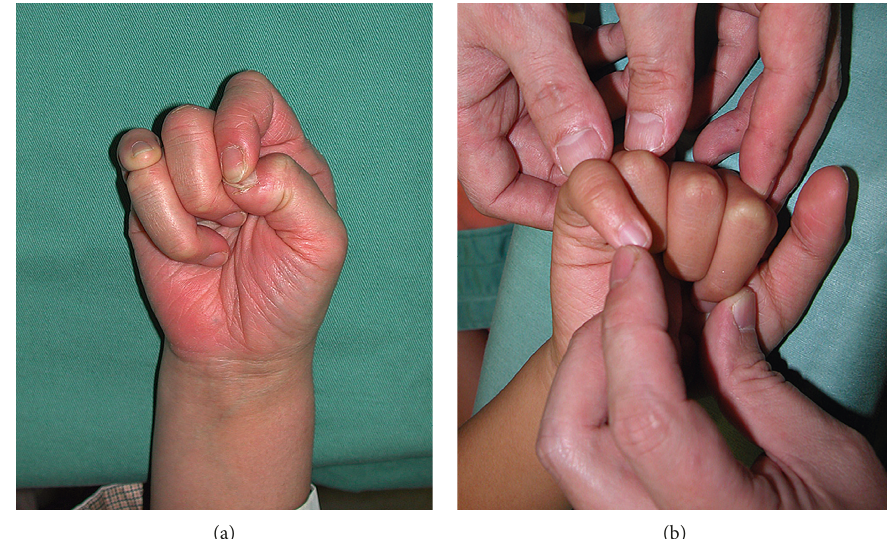
Figure 2: Preoperative photographs of the affected hand in Case 1. (a) Making a fist was difficult due to finger overlapping. (b) Passive finger flexion under general anesthesia revealed marked rotation of the little